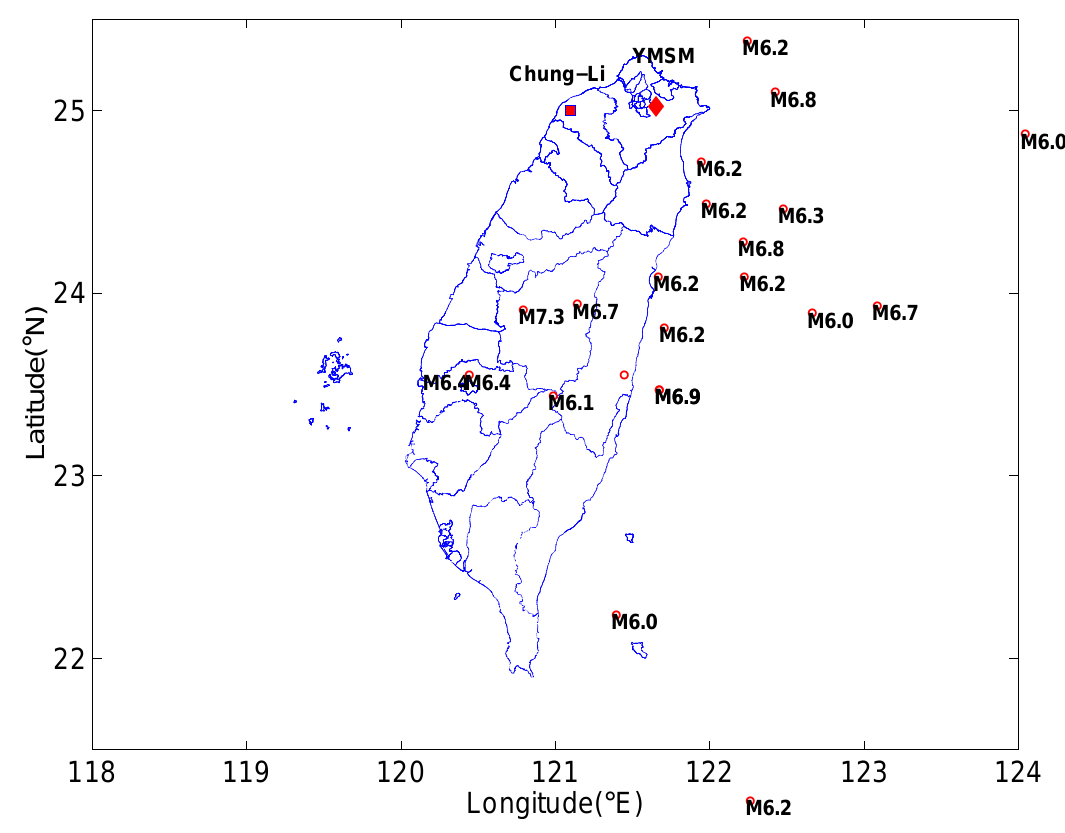
Fig. 1. The locations of the ionosonde, the GPS receiver and the 20M > = 6.0 earthquakes in the Taiwan area during September 1999 and December 2002. The square and diamond symbols denote the Chung-Li ionosonde and YMSM GPS receiver, respectively. Table 1. Catalog of the earthquakes in the Taiwan area used in this